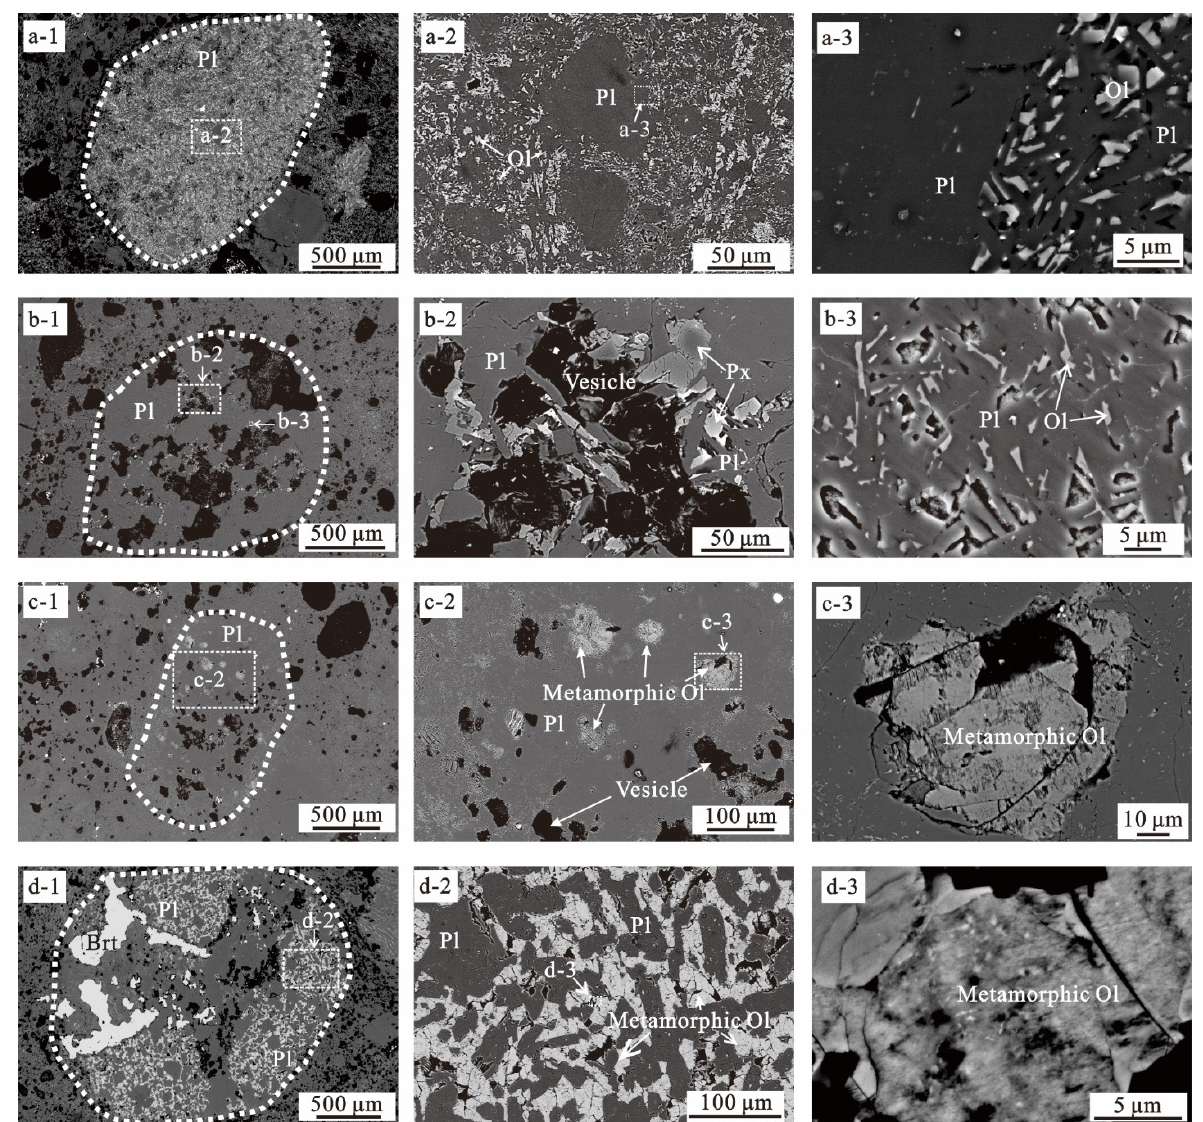
Figure 2. Backscattered electron images of four types of crystalline impact melt clasts. ( a ). The first type, clast 01; ( a-1, a-2 ): pseudo-plagioclase (Pl) mineral clasts; ( a-3 ): there seems to be the accumulation of a large number of plagioclase microcrystals in the left, the poikilitic-like texture of plagioclase-olivine (Ol) on the right. ( b ). The second type, clast 107; ( b-1 ): with a large number of vesicles; ( b-2 ): with the basaltic component, the pyroxenes (Px) show chemical zoning; ( b-3 ): the poikilitic-like texture of plagioclase-olivine, the amount of olivine is less than that in the first type. ( c ). The third type, clast 109; ( c-1 ): a large number of olivine fragments; ( c-2 , c-3 ): metamorphic olivine. ( d ). The fourth type, clast 11; ( d-1 ): the breccia consists of three clasts, and some of the vesicles are filled with barite (Brt); ( d-2 ): an enlarged image of breccia showing the gabbro-like texture of plagioclase and olivine; ( d-3 ): metamorphic olivine.